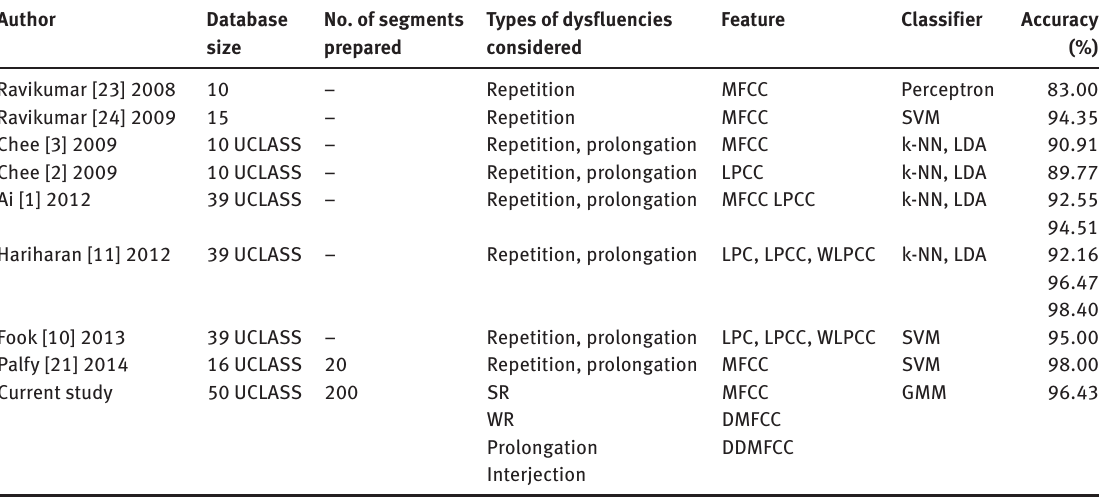
Table 4: Some of the Previous Works Pertaining to the Recognition of Dysfluencies.